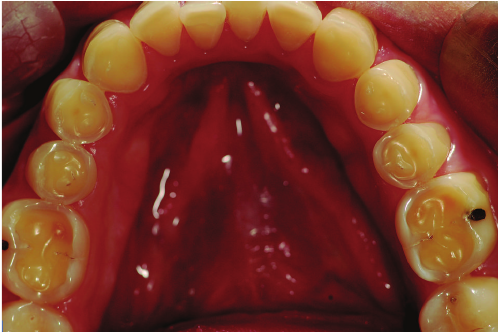
Figure1:Facialviewofdentalerosionandshorteningoftheanterior teeth.